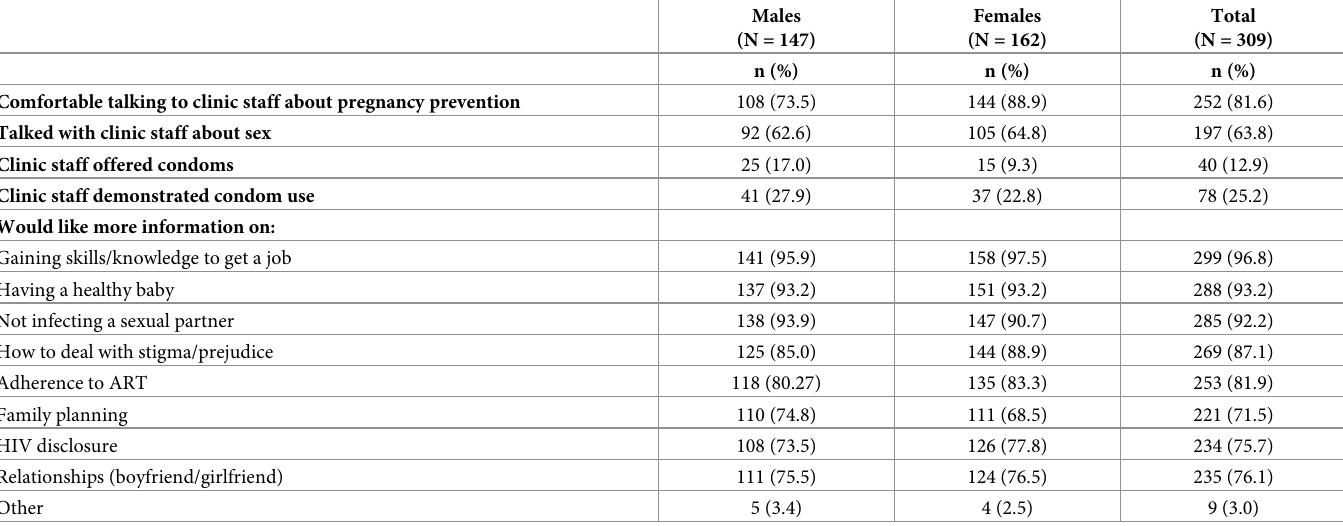
Table 4. SRH clinic experiences and information needs by